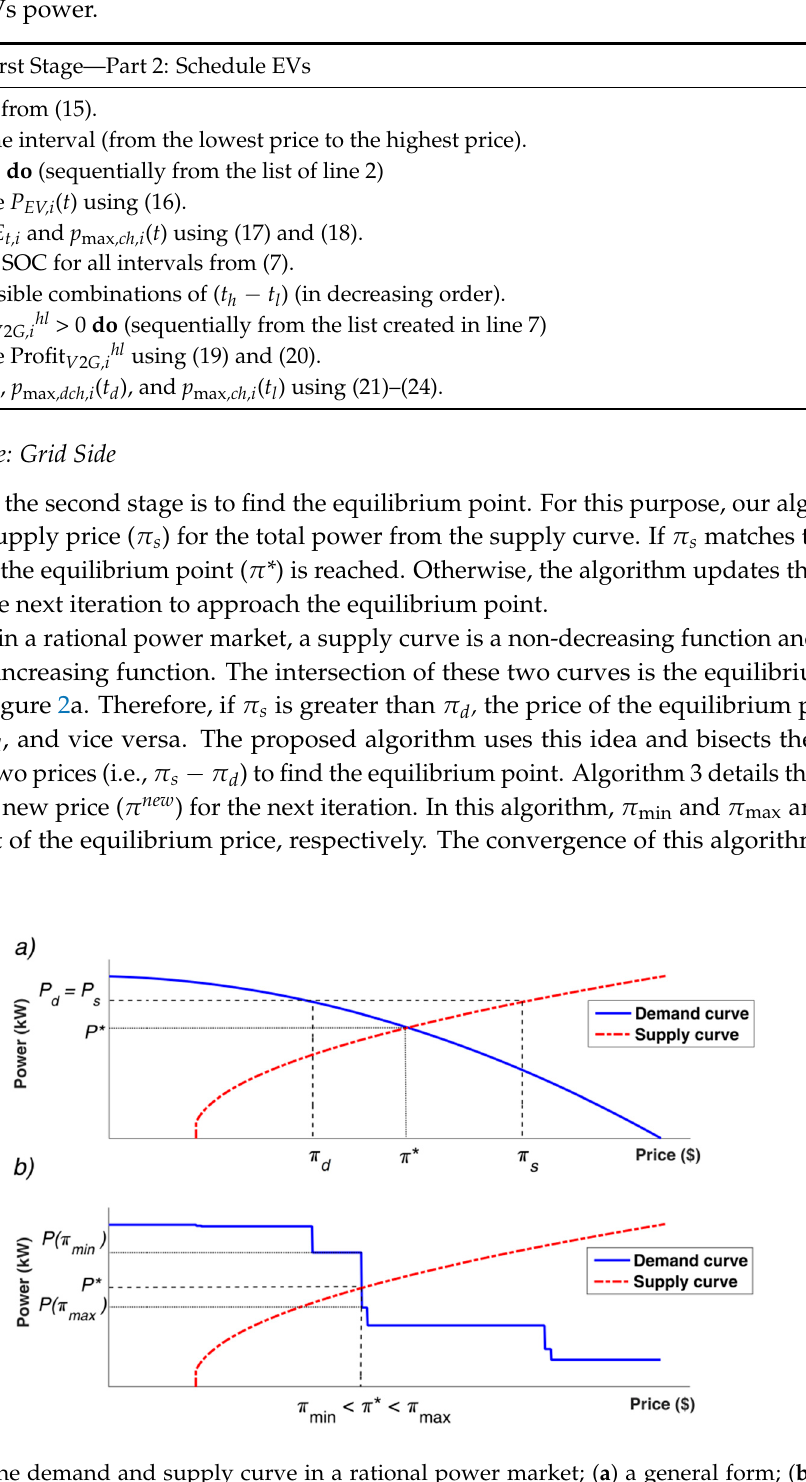
Figure 2. The demand and supply curve in a rational power market; ( a ) a general form; ( b ) when customers decide similarly.